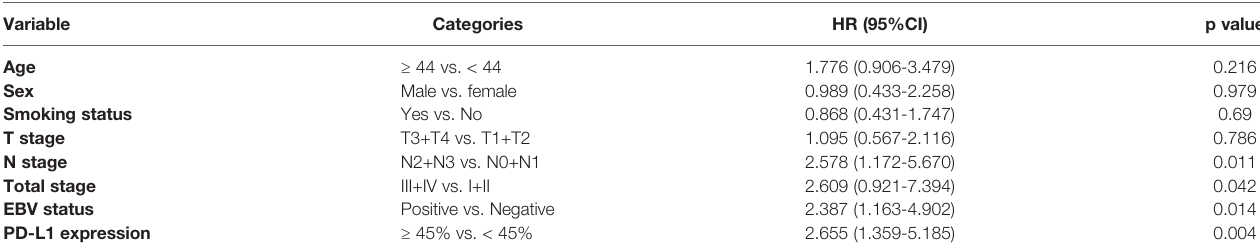
TABLE 2 | Univariate analysis of progression-free survival in patients with NPC. Variable